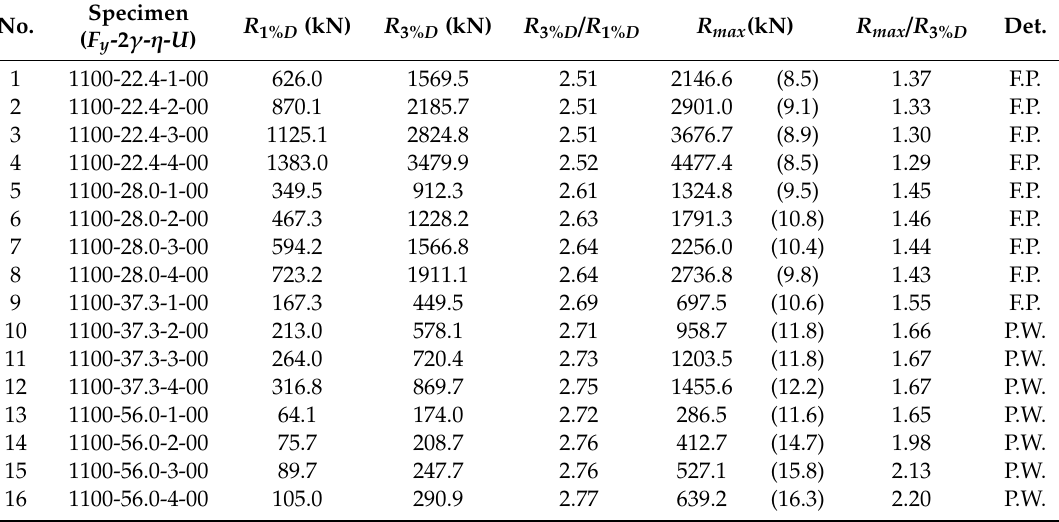
Table 11. Parametric analysis results of S1100 ( F y = 1100